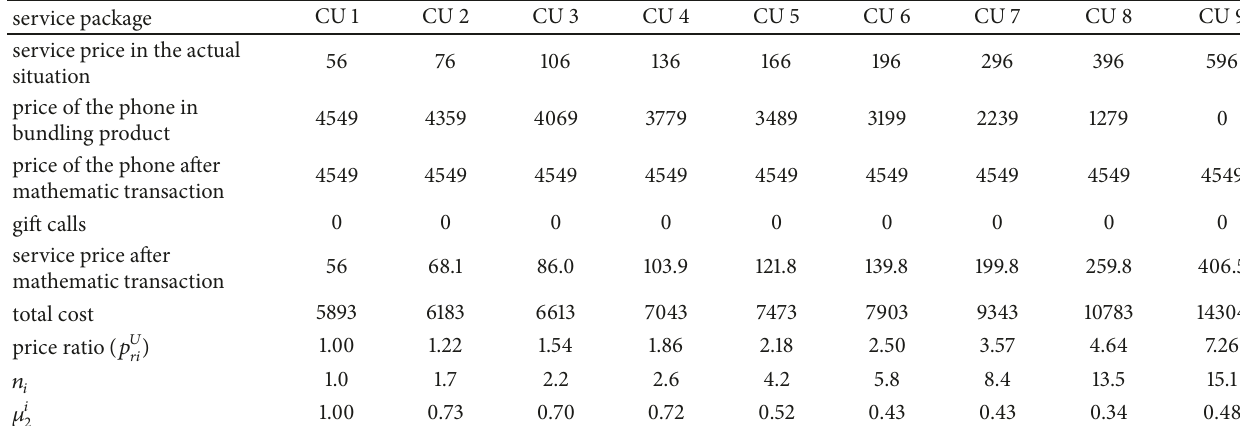
Table 4: Details of the service package offered by